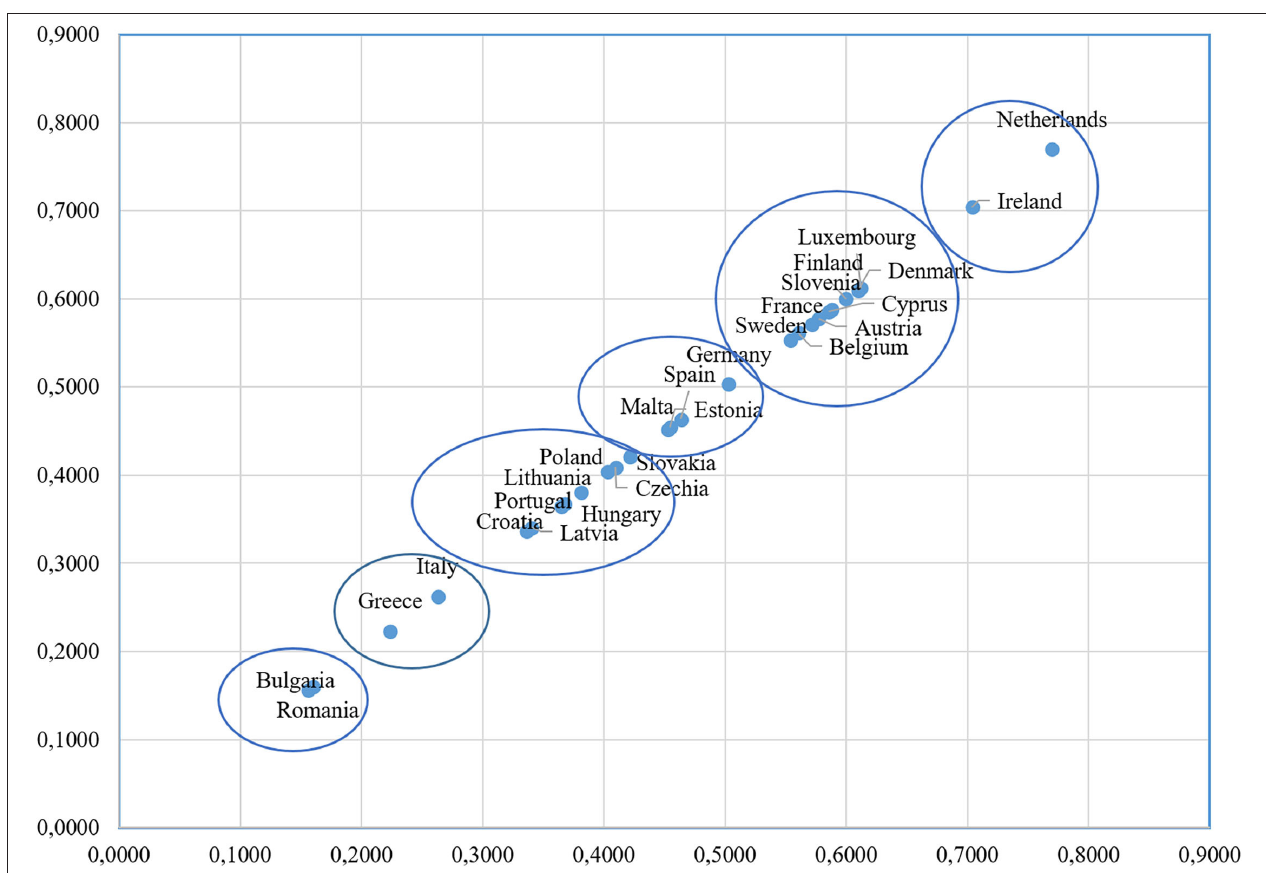
FIGURE 1 | Scatter diagram for a linear ordering of European countries according to the level of patients’ readiness for use digital healthcare services. Source: own